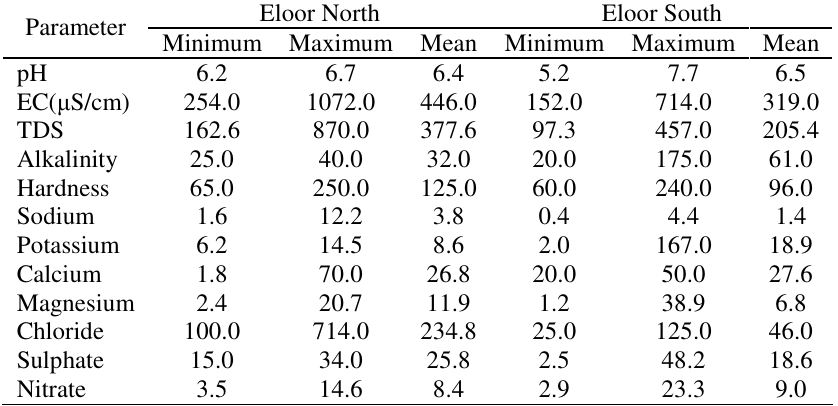
Table 3. The physicochemical parameters of groundwater samples of Eloor (Nothern and Southern region) in ppm.